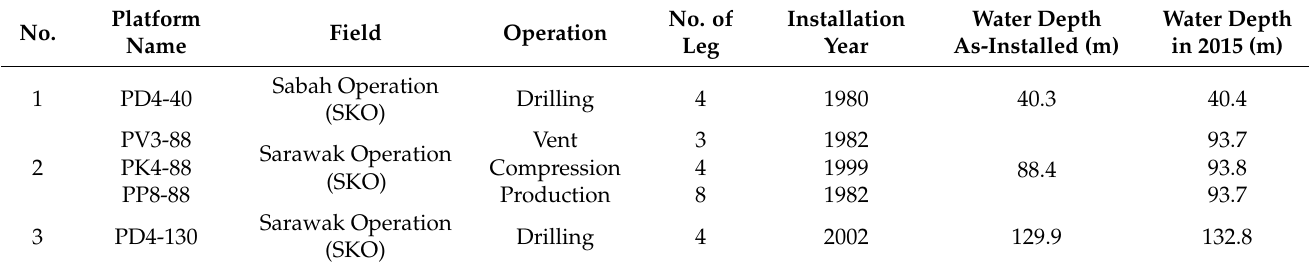
Table 1. Test structures specification.